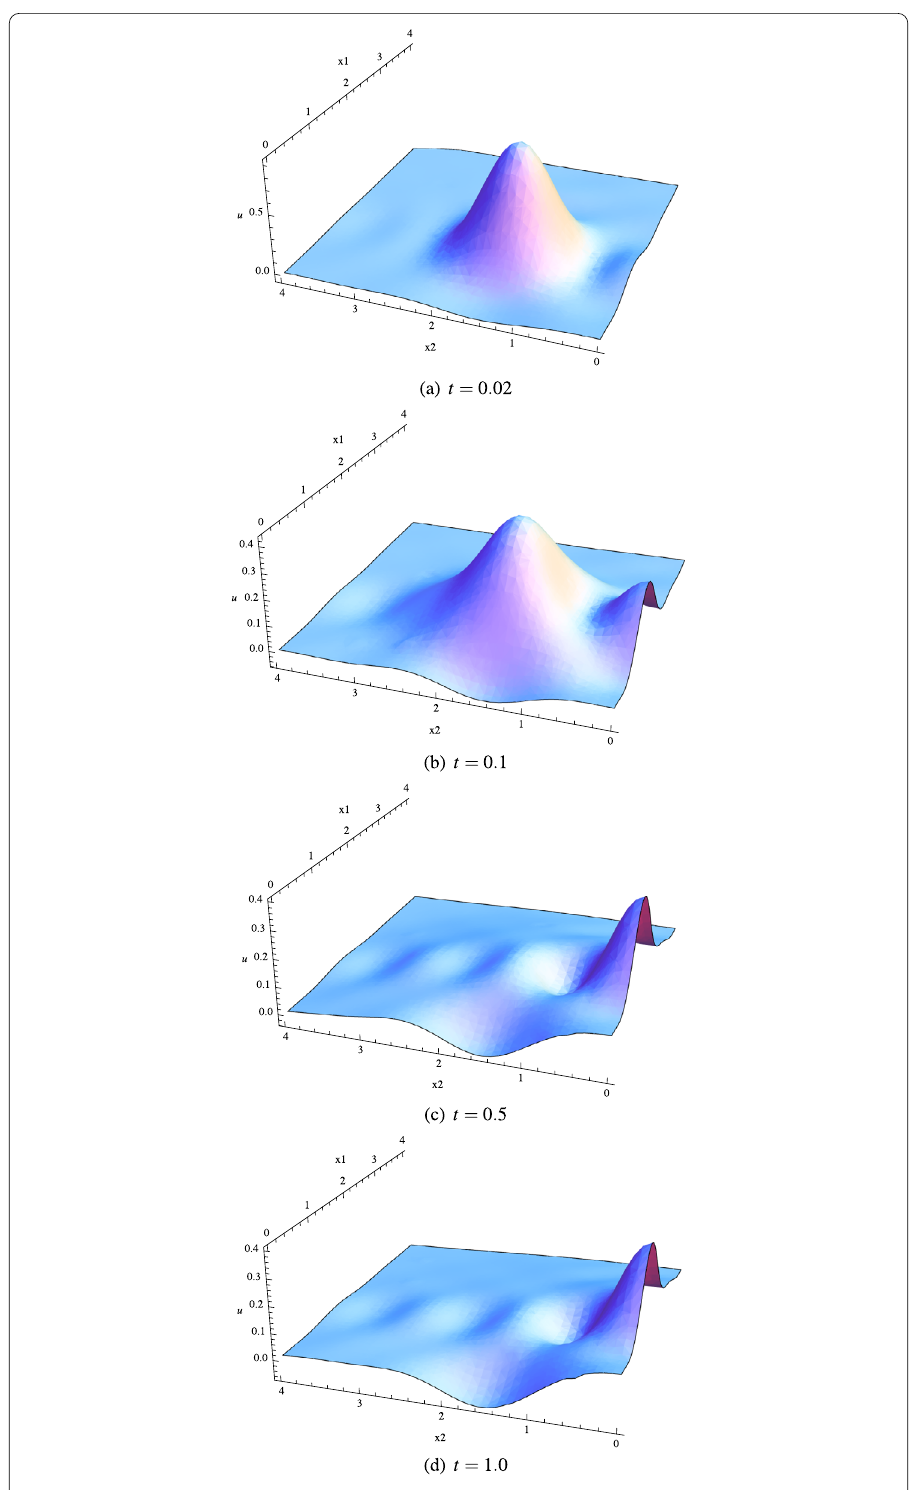
Figure 1 Anomalous diffusion for α =